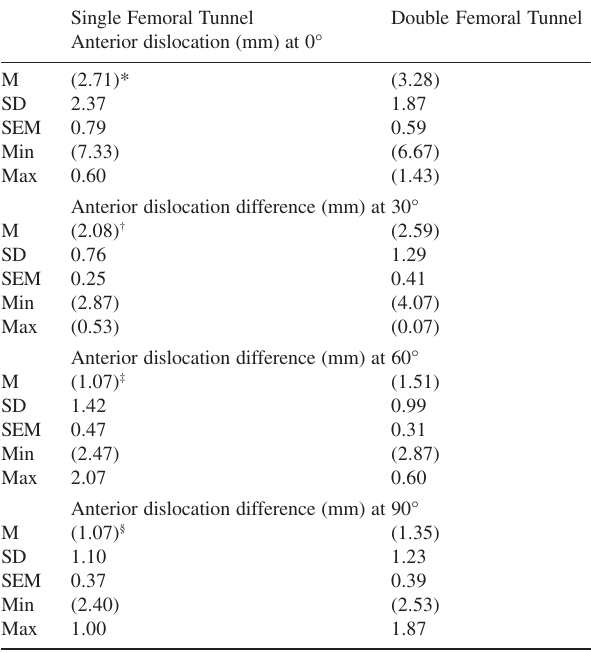
Table 3 - Difference between anterior dislocation before (intact ligament) and after anterior cruciate ligament (ACL) reconstruction at 0°, 30°, 60°, and 90° of flexion in knees subjected to the technique using single and double femoral tunnel